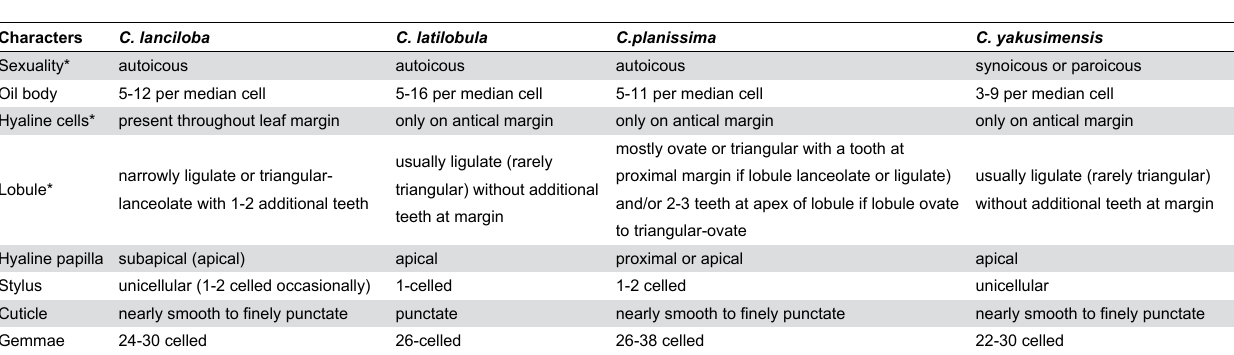
Table 1. Summary of morphological variation of four species